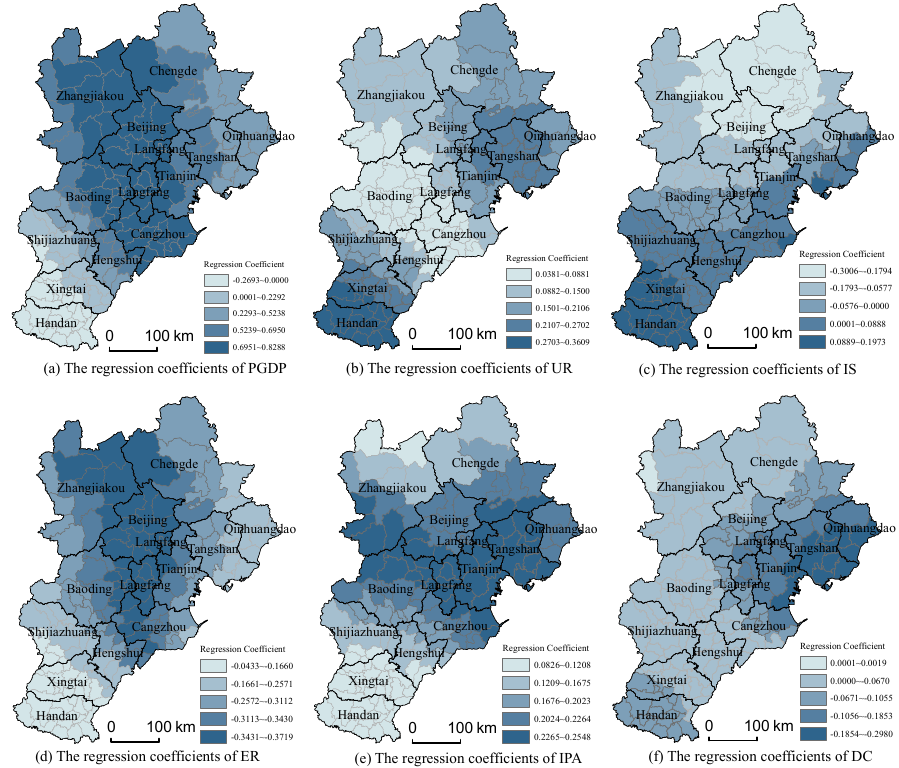
Figure 7. Spatial distribution graph of the regression coefficients of driving factors for NH 3 -N.